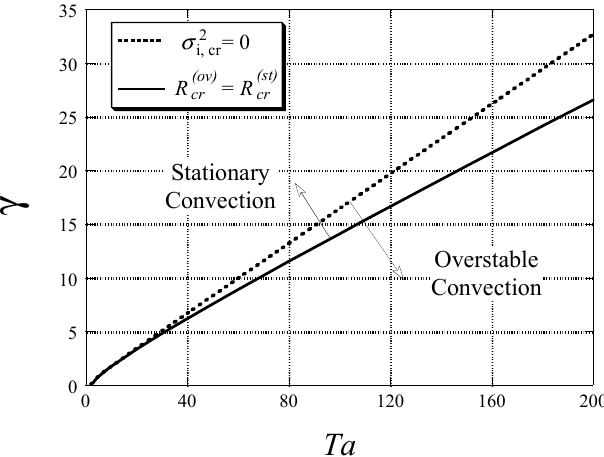
Figure 15. Stability map for gravity driven convection in a rotating porous layer heated from below ( γ = Va / π 2 , R = Ra g / π 2 ) [42]. (Reproduced with permission from Cambridge University